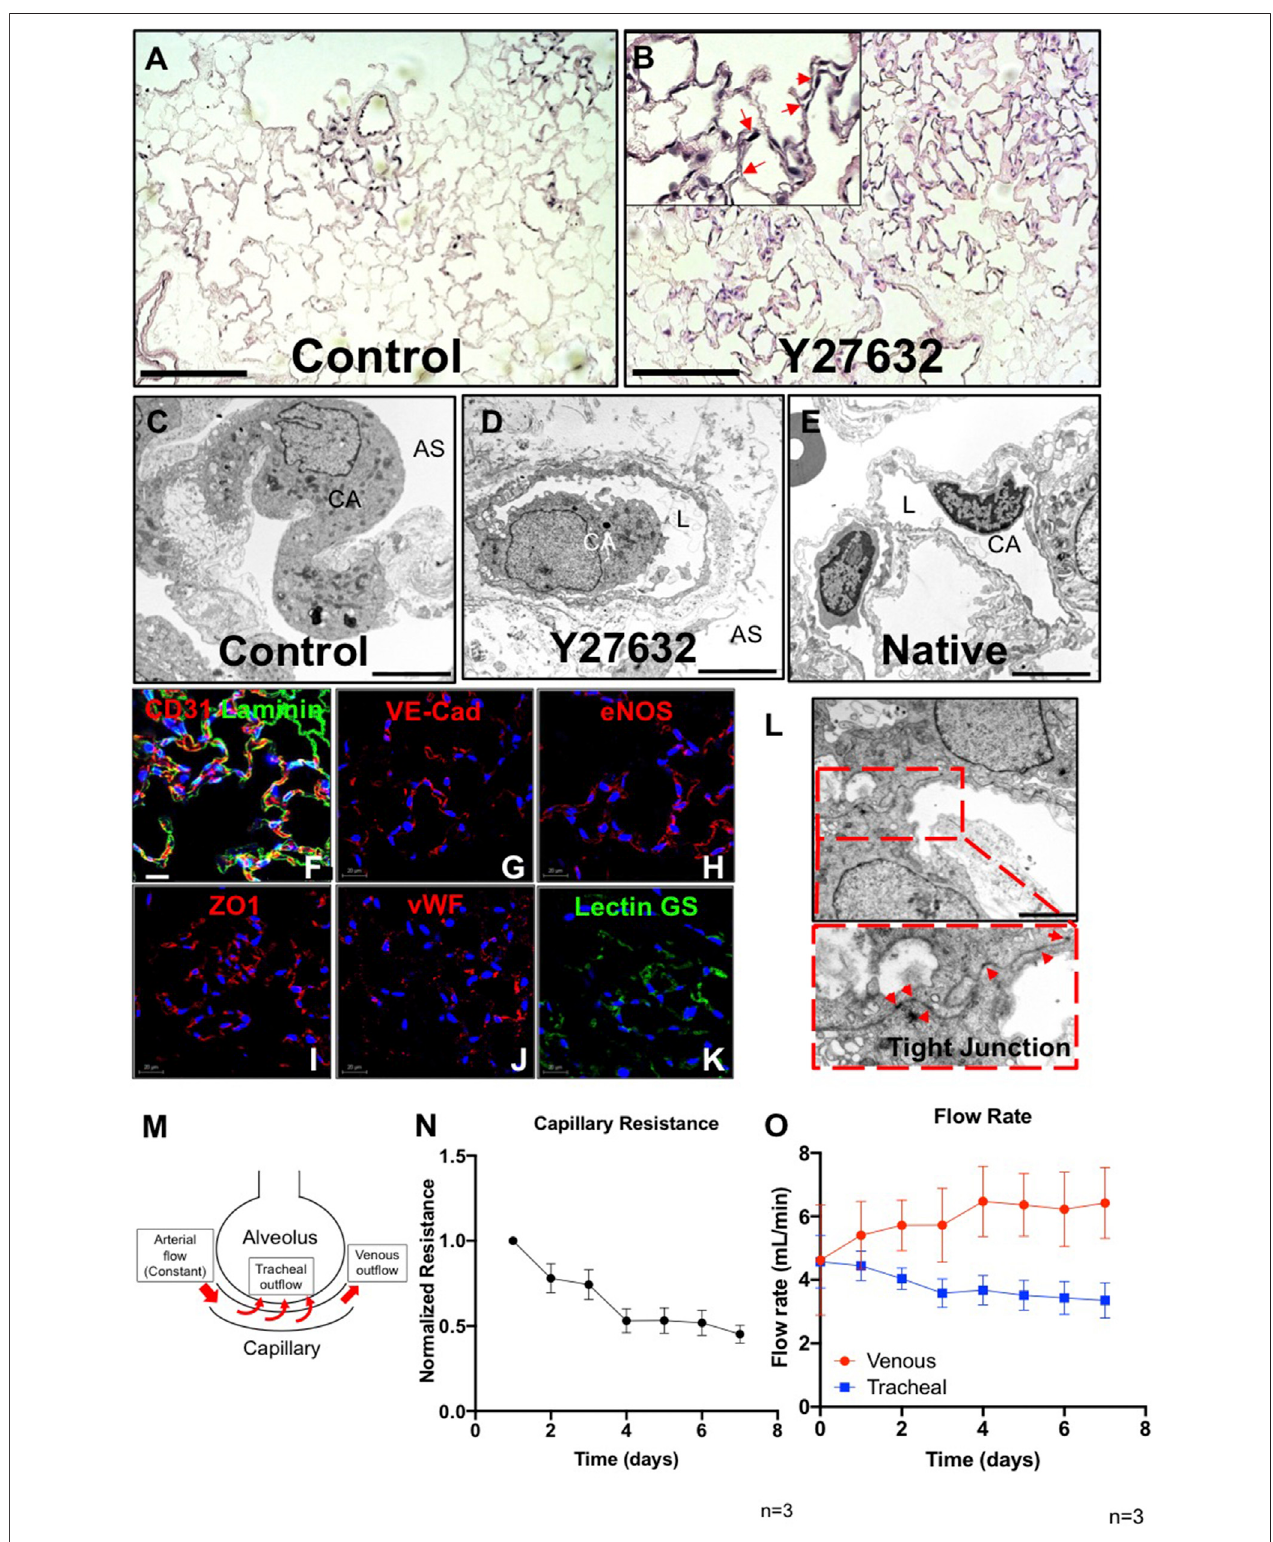
FIGURE 2 | Characterization of PMEC-repopulated lungs. (A,B) H/E image of a representative section in control (A) and Y27632-treated repopulated lungs (B) . Scale bars 150 μ m, arrows point to reconstituted capillary lumens. (C,D,E) TEM images of control, Y27632-treated repopulated lungs, and native lungs, respectively.